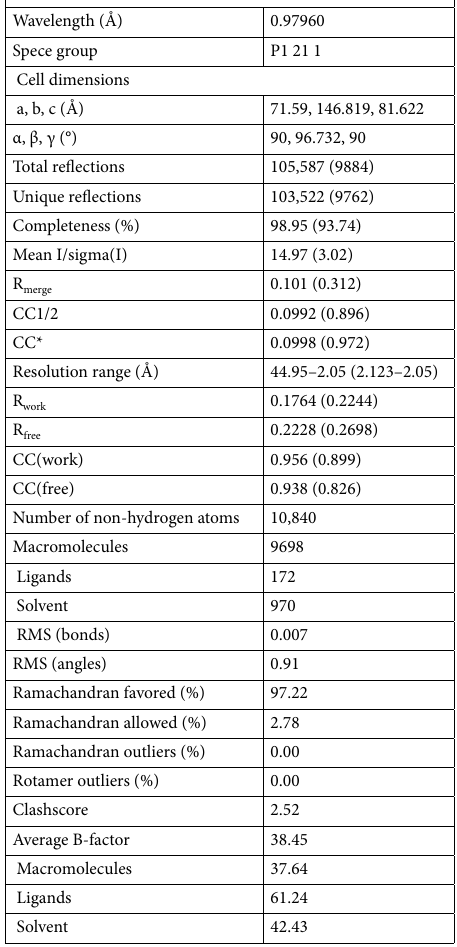
No. of passage Mutated virus Amino acid mutation on RBD region No. of mutant/no. of plaque